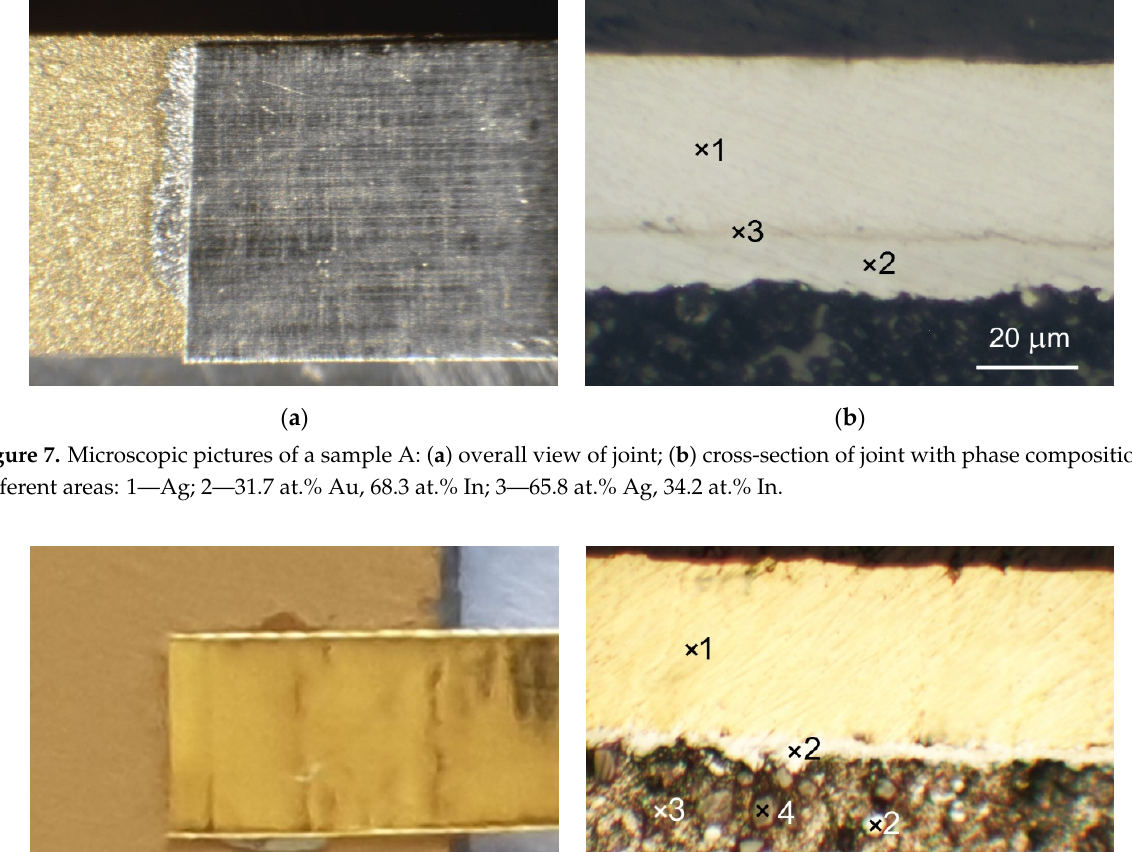
Figure 7. Microscopic pictures of a sample A: ( a ) overall view of joint; ( b ) cross-section of joint with phase composition of different areas: 1—Ag; 2—31.7 at.% Au, 68.3 at.% In; 3—65.8 at.% Ag, 34.2 at.% In.